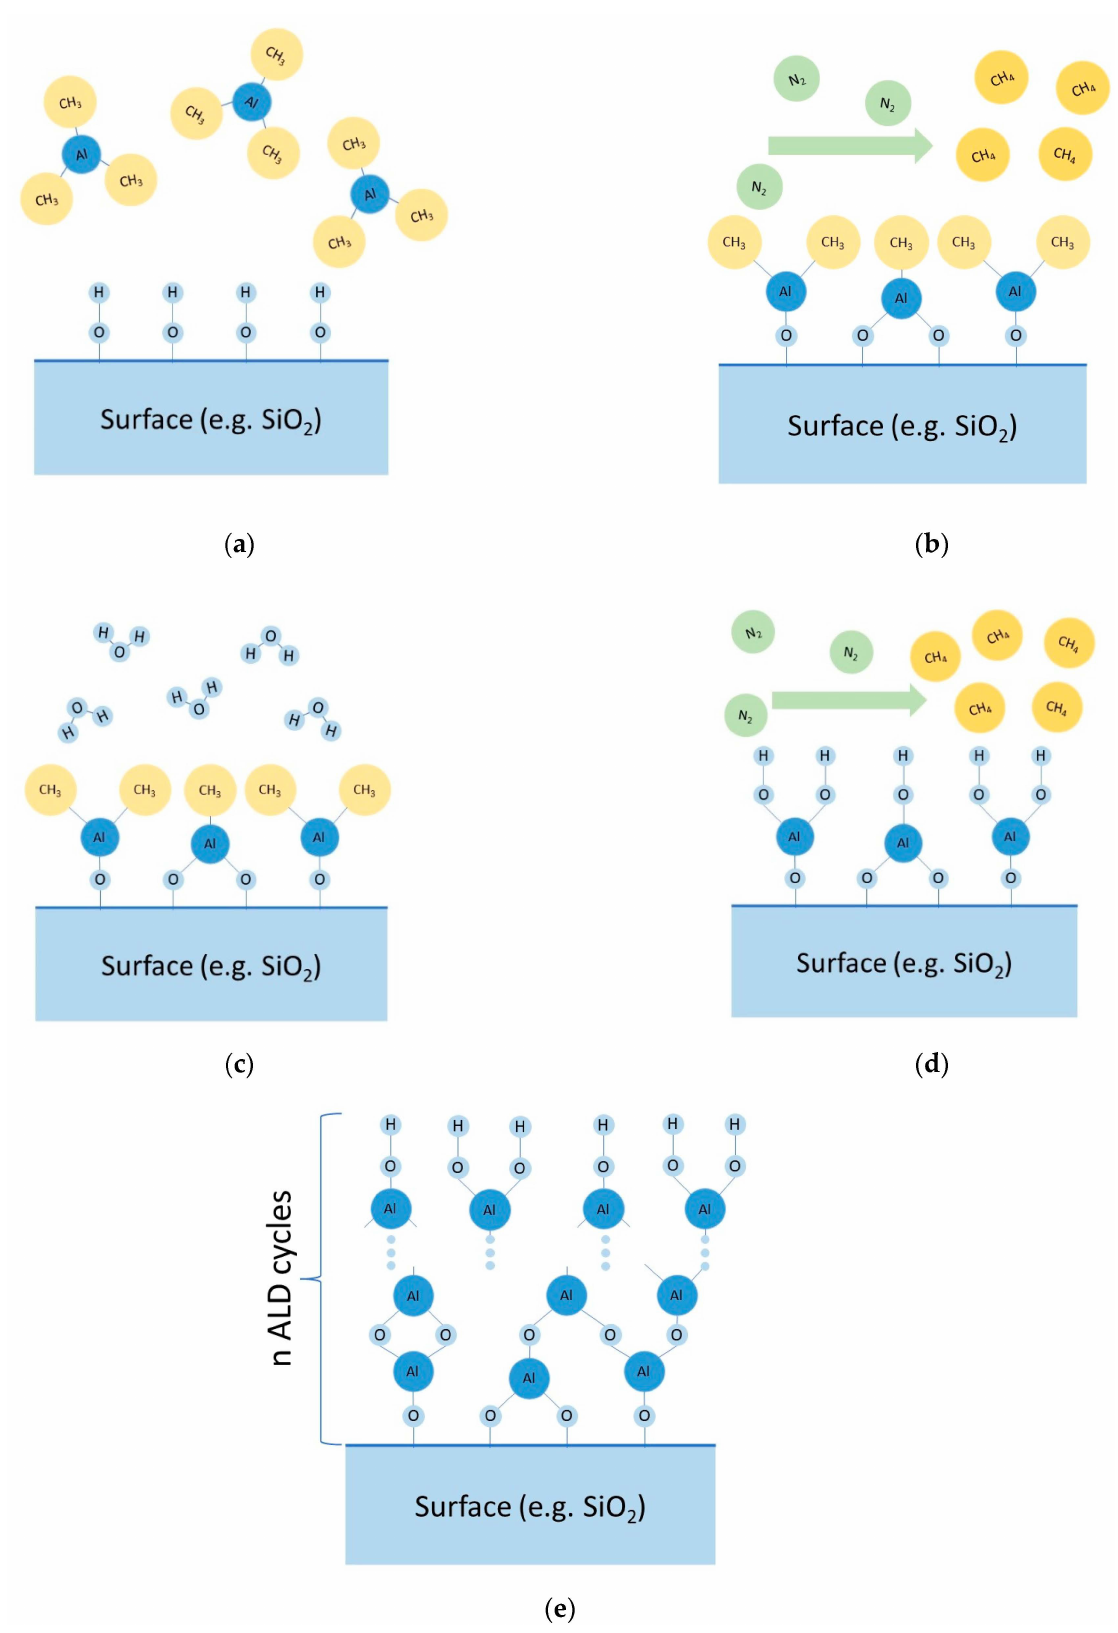
Figure 2. Principal scheme of main stages of ALD: ( a ) Stage II, ( b ) Stage III, ( c ) Stage IV, ( d ) Stage V, ( e ) future